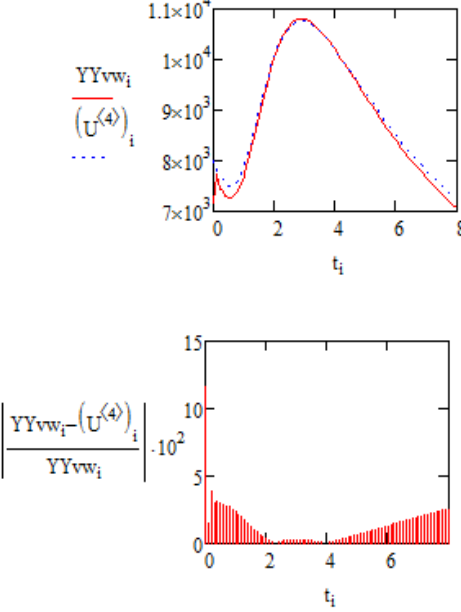
Fig. 1. Comparison of the estimated solutions, Y Y w i , with the “experimental data”, U < 3 > error.